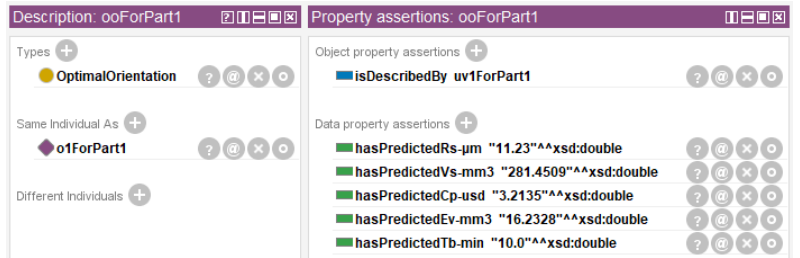
Figure 11. Generated optimal build orientation for Part